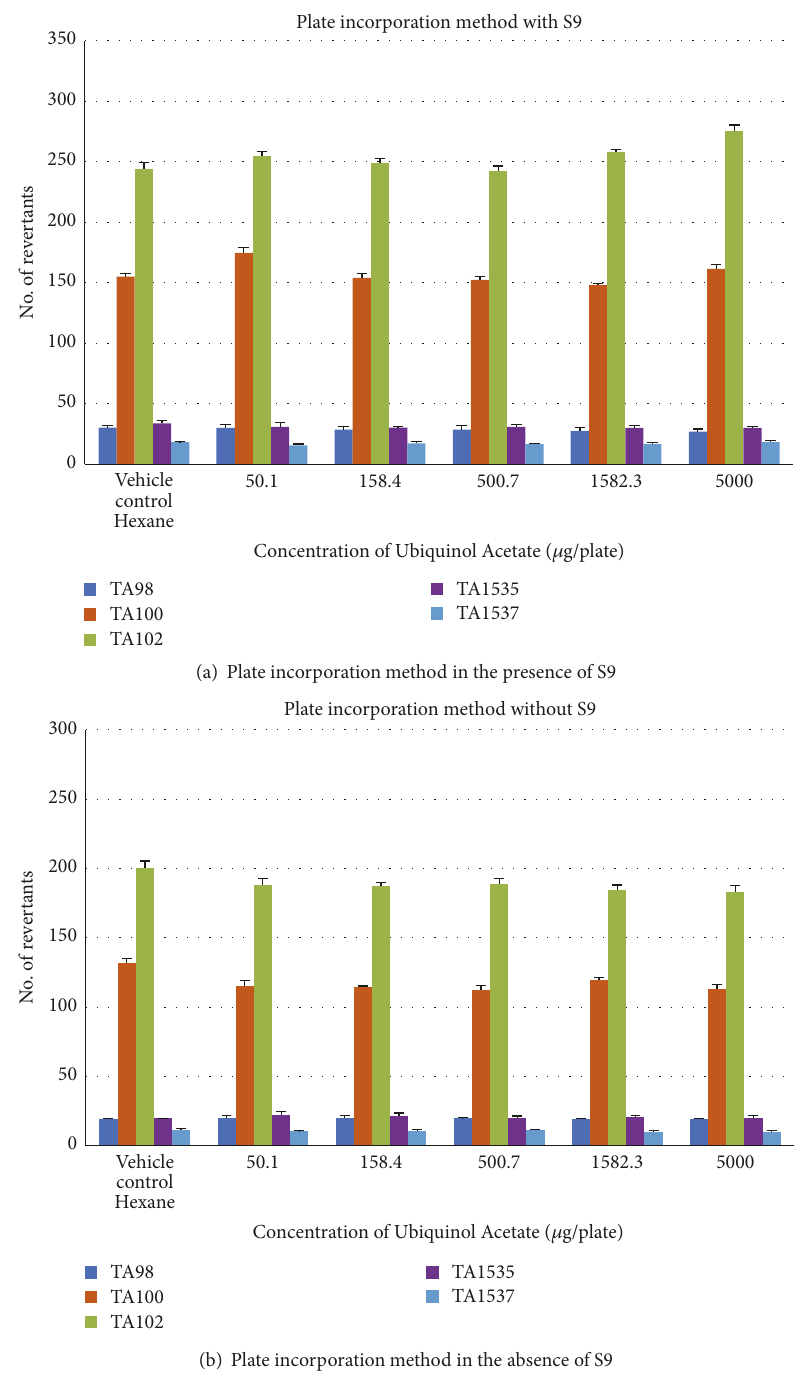
Figure 3: Effect of ubiquinol acetate on number of revertants in plate incorporation method using Salmonella typhimurium tester strains in the presence (a) and absence (b) of metabolic activation. Each concentration was tested in triplicate (n = 3) and the values are represented as mean ±